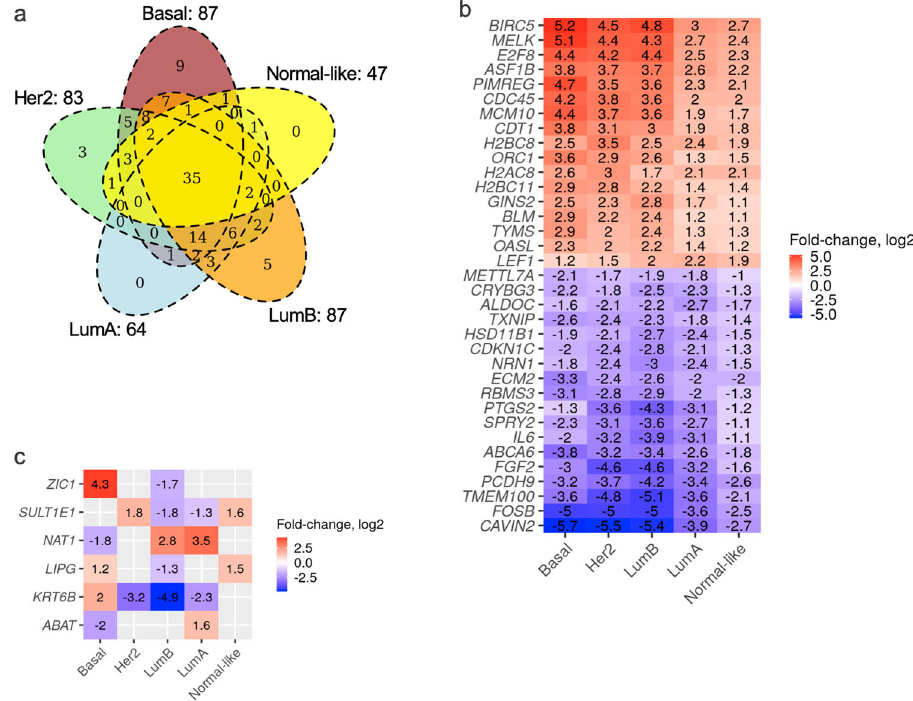
Fig. 3 Intersection among DE-SN. a Venn diagrams depicting the common DE-SN after comparing PAM50 subtypes to Normal-adjacent samples. b and c Heatmaps depicting the expression fold-change for DE-SN that are signi fi cantly changed in all PAM50 subtypes ( b ) or for DE- SN that are dynamically differentially expressed across PAM50 subtypes ( c